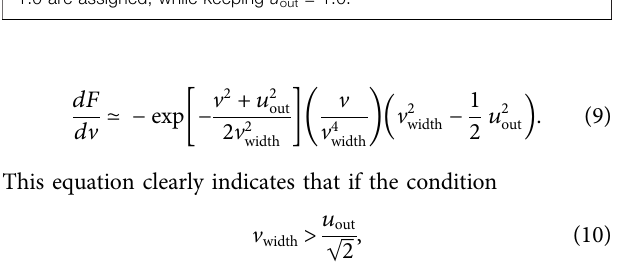
FIGURE 4 | The left panels depict a bird ’ s eye view of the function G ( v x , v y ) and the right panels plot graphs of the function F ( v ) expressing the cross-section of G ( v x , v y ) (A) : v width = 0.5 (B) : v width = 0.7, and (C) : v width = 1.0 are assigned, while keeping u out =